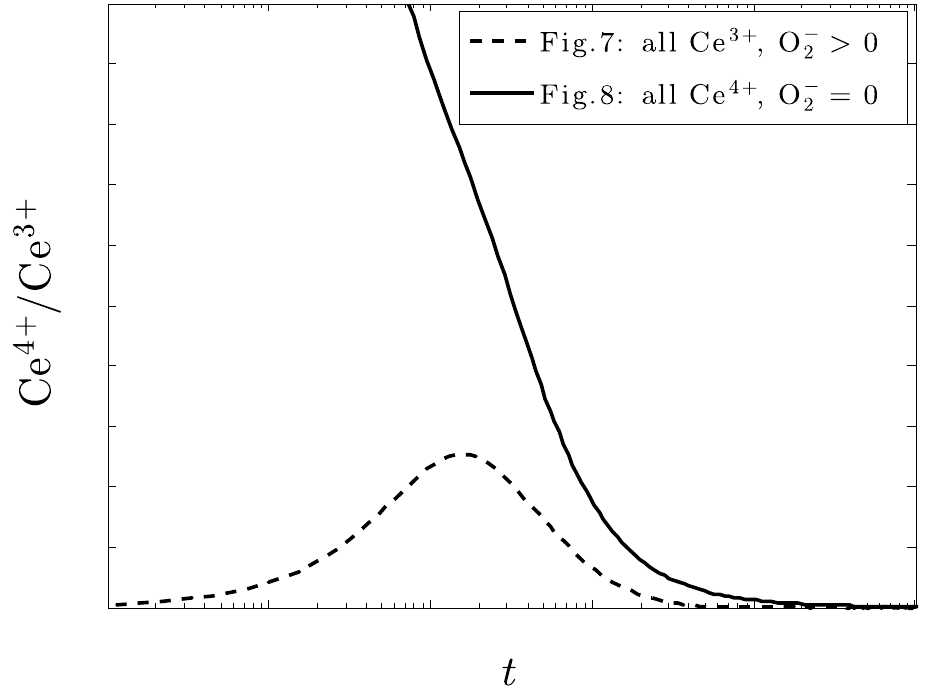
Figure 9. The calculated ratio of Ce 3 + / Ce 4 + corresponding to the situation in Figure 7 (all Ce 3 + initially) and Figure 8 (all Ce 4 + ) when the system is overrun with superoxide.